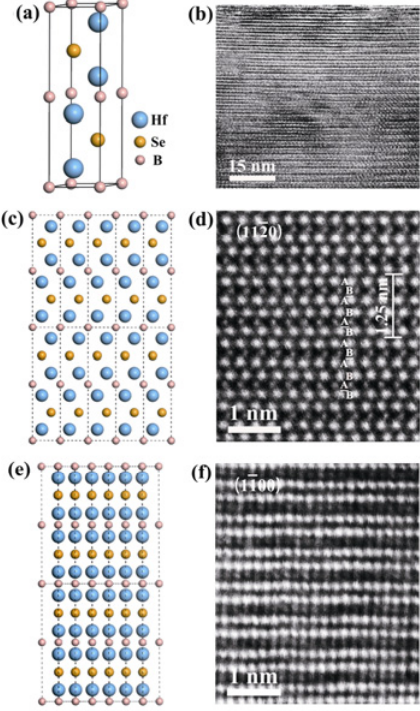
Fig. 6 SEM images of the fracture surfaces of (a) Zr 2 SeB and (c) Hf 2 SeB and corresponding EDS results of (b) Zr 2 SeB and (d) Hf 2 SeB. The positions for the EDS analysis are labeled by white crosses in (a) and (c).